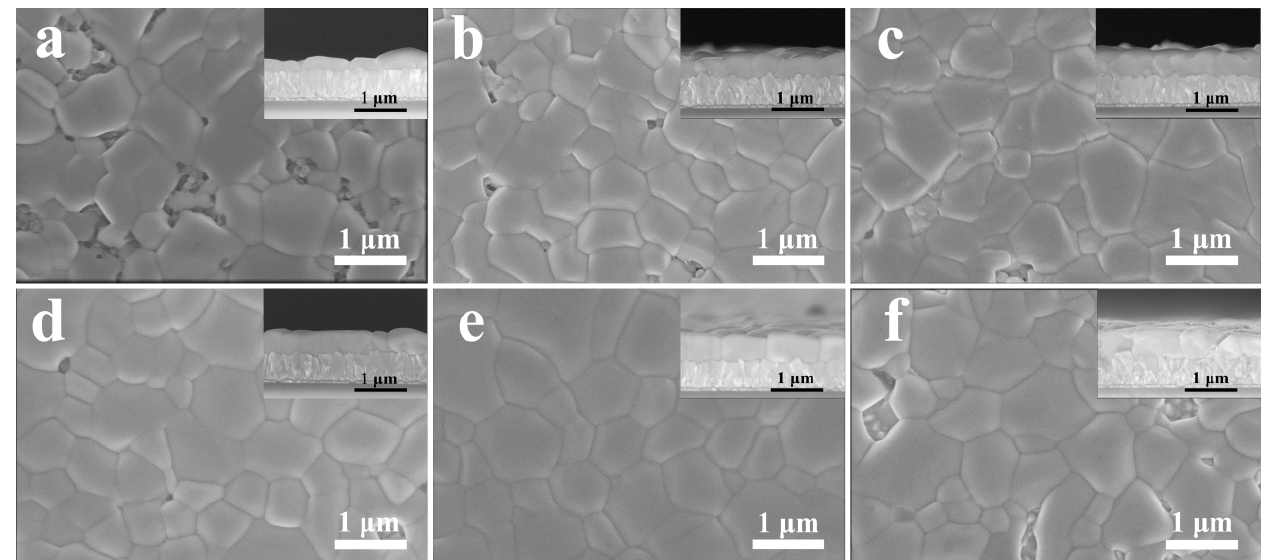
Figure 2. Top-view and cross-sectional (insets) SEM images of CsPbBr 3 films synthesized with different PbBr 2 concentration: ( a ) 1.0 M w/o InBr 3 ; ( b ) 1.0 M w/ InBr 3 ; ( c ) 1.1 M w/ InBr 3 ; ( d ) 1.2 M w/ InBr 3 ; ( e ) 1.3 M w/ InBr 3 ; ( f ) 1.4 M w/ InBr 3 .